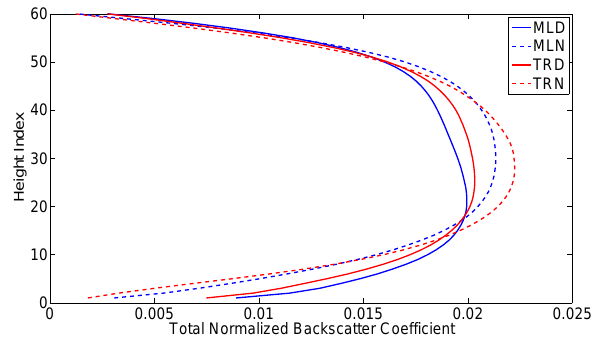
Fig. 4. Annual mean backscatter profile for midlatitude (blue) and tropical (red) cirrus clouds at daytime (solid lines) and nighttime (dashed lines).